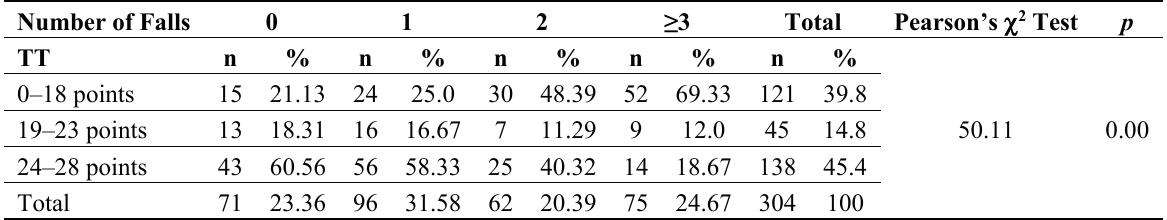
Table 6. The correlation between the number of falls and the results of the TT (Pearson’s correlation